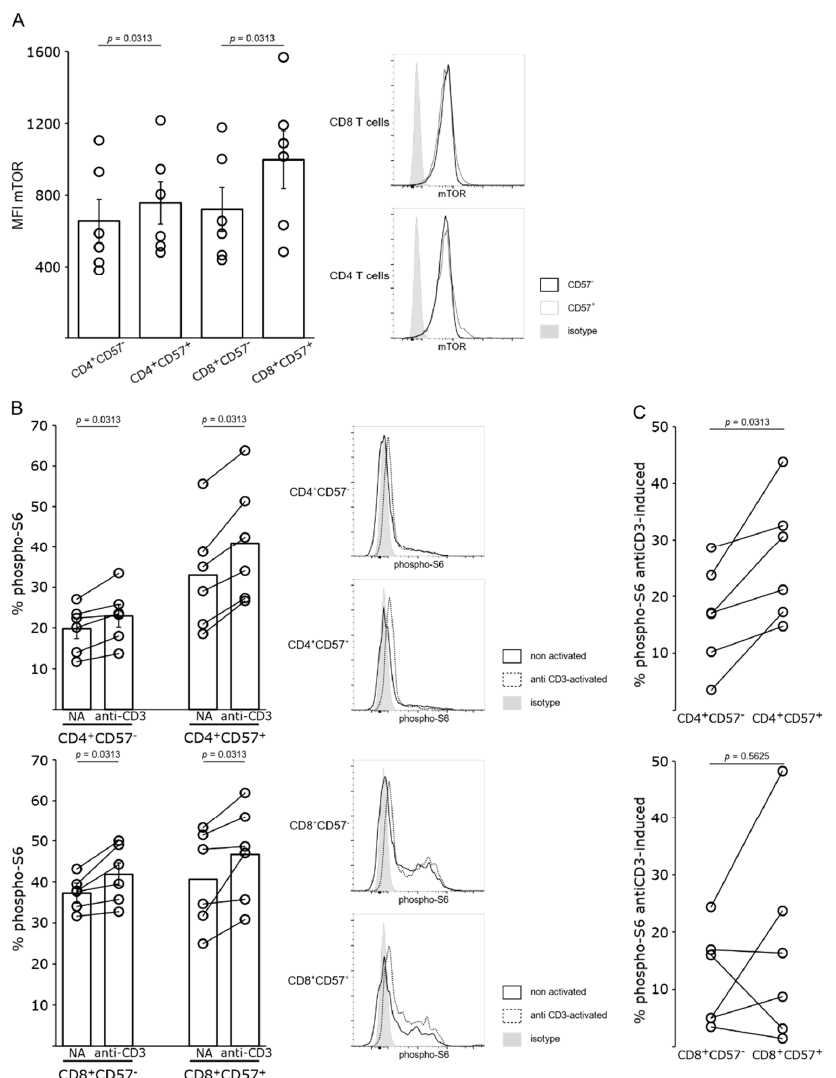
Figure 3. mTOR expression and activation of mTORC1 pathway in CD57 + and CD57 − T cells. ( A ) mTOR expression by CD4 + CD57 − , CD4 + CD57 + , CD8 + CD57 − and CD8 + CD57 + T cells was analyzed by fl ow cytometry. Left panel, mean of fl uorescence intensity (MFI) of cells of six healthy donors, the mean (bar chart) and SEM are shown . Right panel, representative fl ow cytometry pro fi le. ( B ) Phos- phorylation of S6 in CD4 + CD57 − , CD4 + CD57 + , CD8 + CD57 − and CD8 + CD57 + T cells were analyzed with and without anti-CD3 activation by fl ow cytometry. Left panel, percentage of positive cells of six healthy donors, the mean (bar chart) and SEM are shown. Right panel, representative fl ow cy- tometry pro fi le. ( C ) Percentage of S6-phosphorylation induced by anti-CD3 activation calculated for each experiment was depicted.